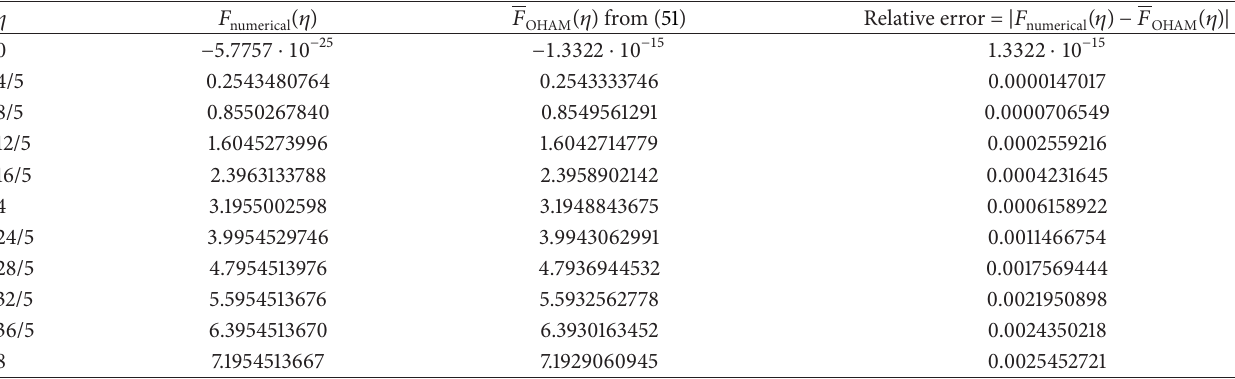
Table 3: Comparison between OHAM results given by (51) and numerical solutions for 𝛽 = 1/2 .